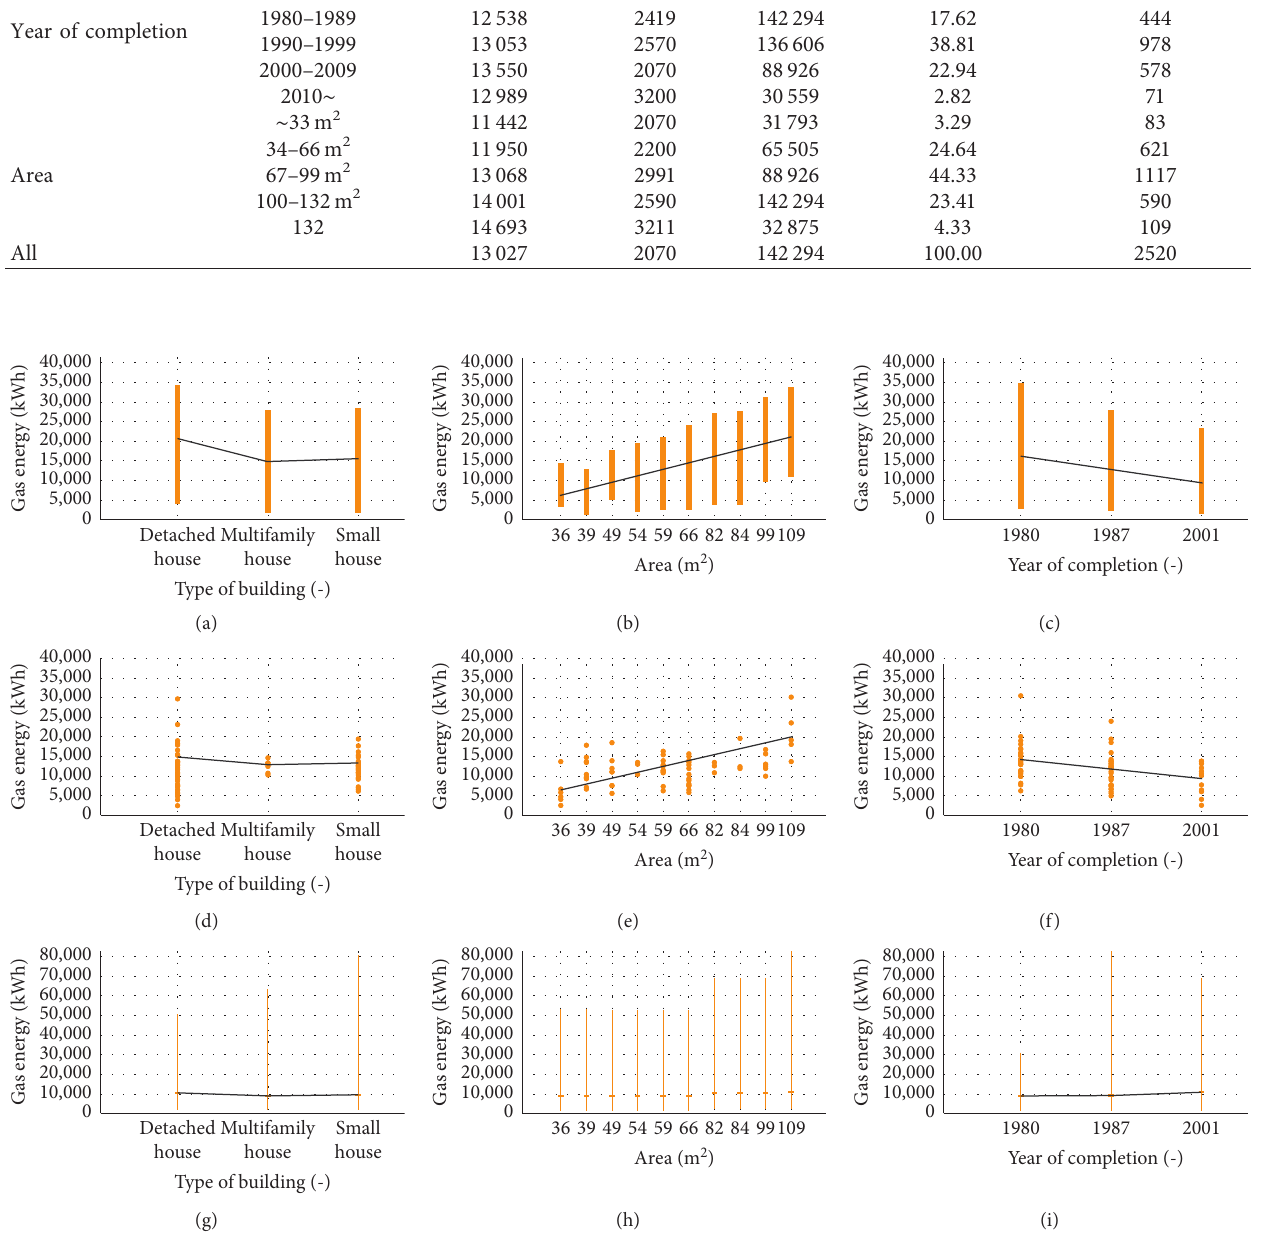
Figure 9: Analysis of gas energy usage patterns based on data. (a) Standard model: type of building. (b) Standard model: area. (c) Standard model: year of completion. (d) Collected data: type of building. (e) Collected data: area. (f) Collected data: year of completion. (g) National Statistics: type of building. (h) National Statistics: area. (i) National Statistics: year of